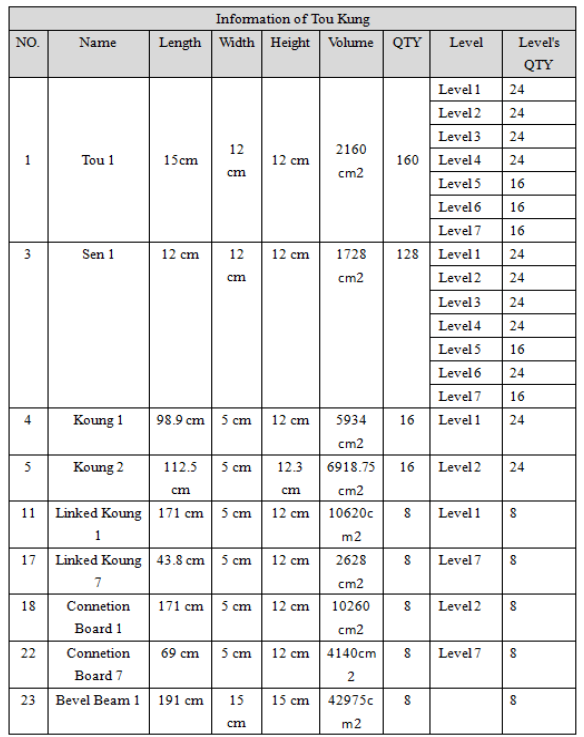
Table 4. Metadata representationof Tou Kung elements